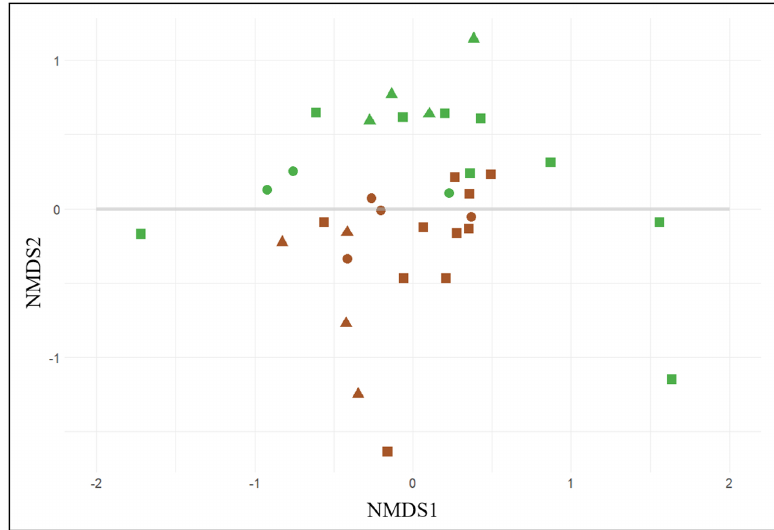
Figure 4. Beta diversity calculated on bacterial datasets shown in a non-parametric multi-dimensional scale (NMDS) using Bray–Curtis distance. Wine related family bacteria exhibited significant seasonal ( p -value = 0.001) variations in soil samples, but this variation was not evident between soil types ( p -value = 0.058). Seasons (summer (brown) and winter (green)). Soil types (calcareous ( and sandy ( (cid:31)